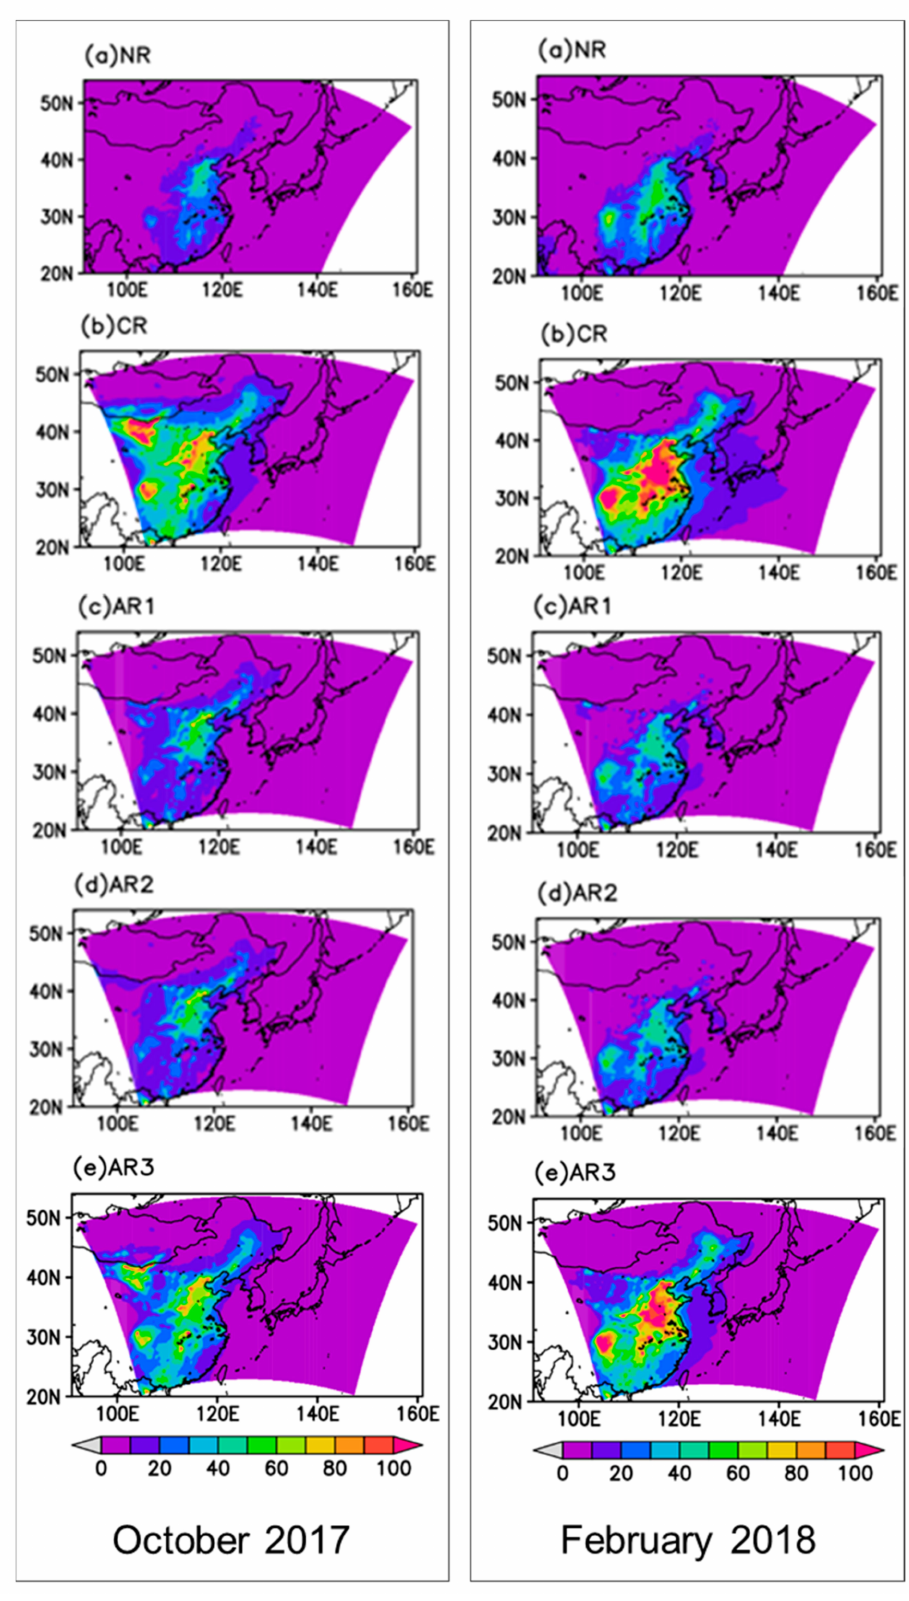
Figure 5. The distribution of the average PM 2.5 concentrations in East Asia for the NR and ARs (i.e., AR1, AR2, and AR3) at 00:00 universal time coordinated (UTC) from October 2017 to February 2018 (unit: µ g/m 3